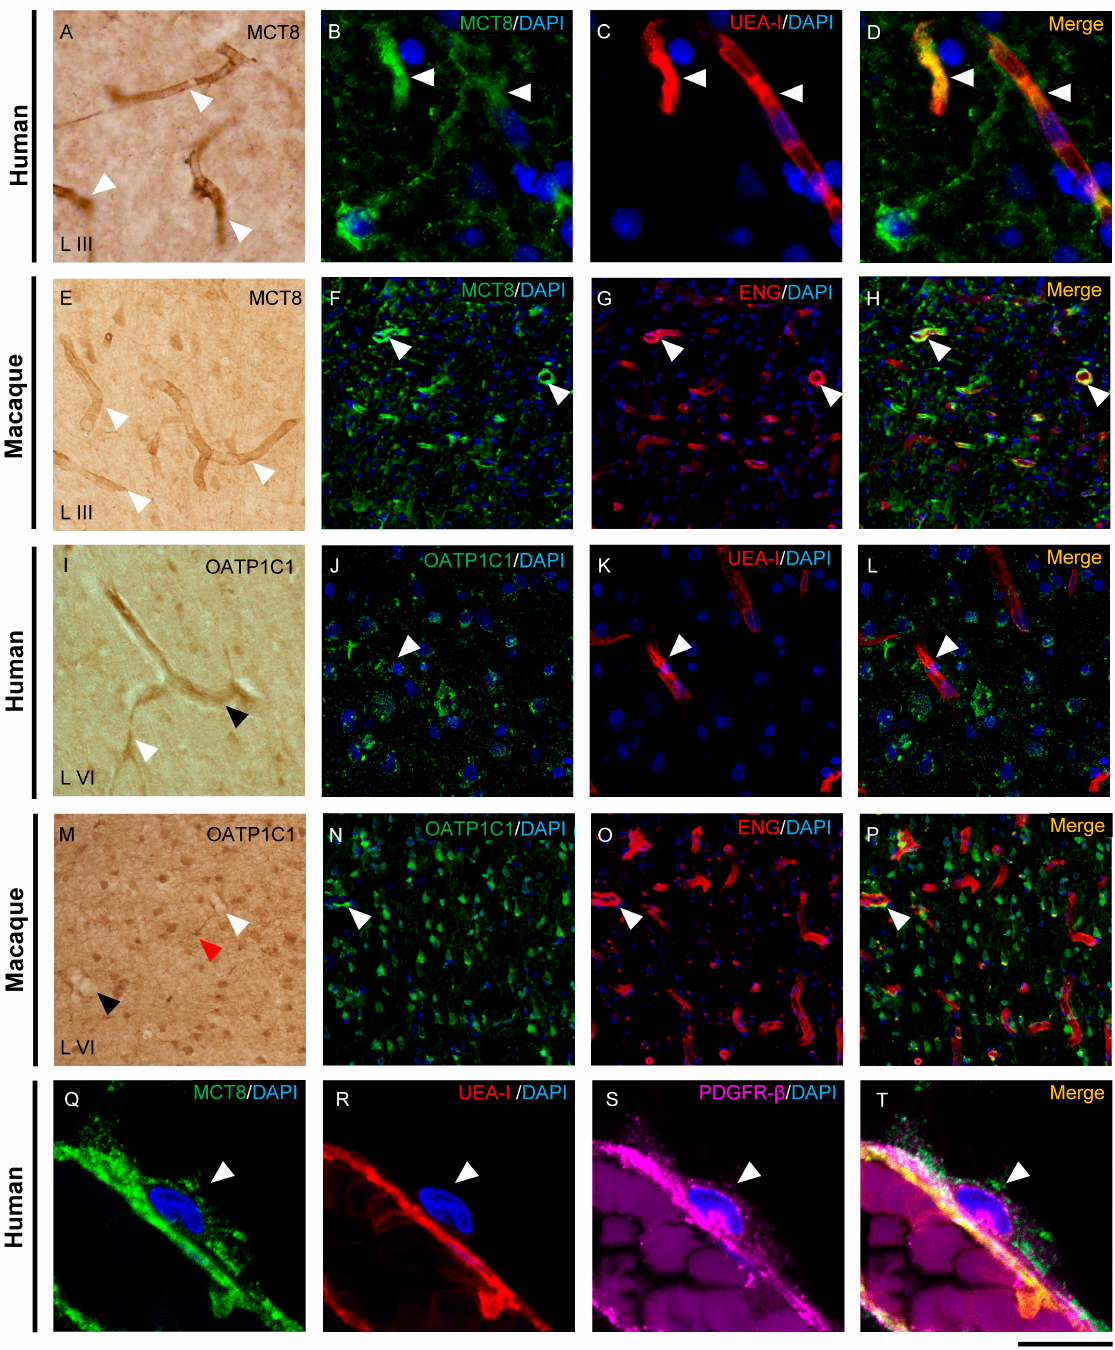
Figure 2. Expression of MCT8 and OATP1C1 in the cerebral barriers of the human and macaque motor cortex. Representative brightfield ( A , E , I , M ) and fluorescence confocal microscope ( B – D , F – H , J – L , N – P , Q – T ) photomicrographs showing immunostaining for MCT8 ( A – H , Q – T ) and OATP1C1 ( I – P ) in blood vessels of human and macaque motor cortex. ( A , E ) show strong MCT8 staining in the endothelial layer of small vessels and capillaries (white arrowheads) in humans and macaques, respectively. ( B – D , F – H ) show colocalization of MCT8 (green) with the endothelial markers UEA-I (red) and ENG (red). ( I , M ) show weak OATP1C1 staining in small vessels (white arrowheads) and venules (black arrowheads). The red arrowhead in M points to a glial cell positive for OATP1C1 with processes surrounding the capillary. ( J – L , N – P ) show colocalization of OATP1C1 (green) with UEA-I (red) and endoglin (red) in a few blood vessels of the human and macaque motor cortex, respectively. White arrowheads point to vessels. In both human and macaque brain tissues, MCT8-